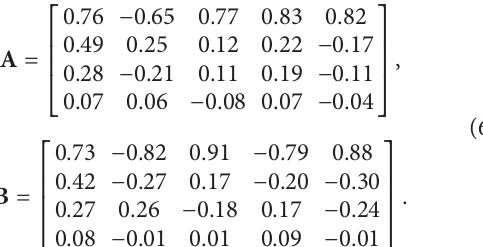
Table 1: The correlation coefficients between the corresponding source pairs of X and Y